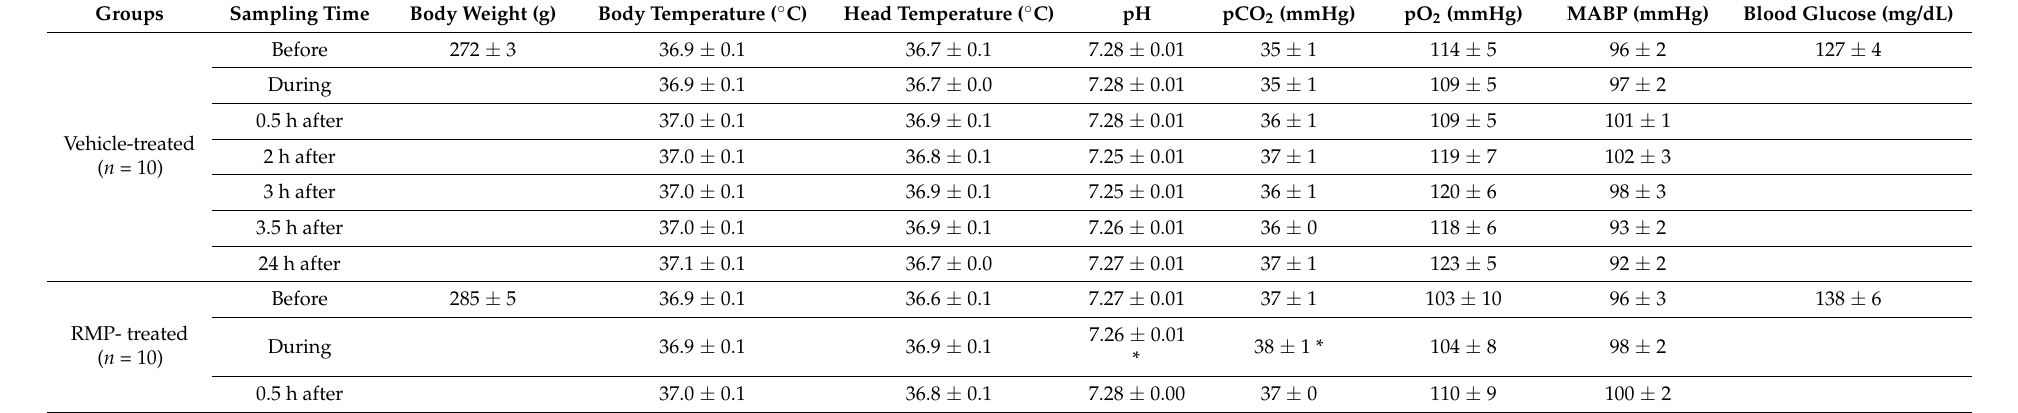
Table 2. Physiological parameters before, during, and after collagenase injection and during vehicle/RMP treatment in female rats employed in the efficacy